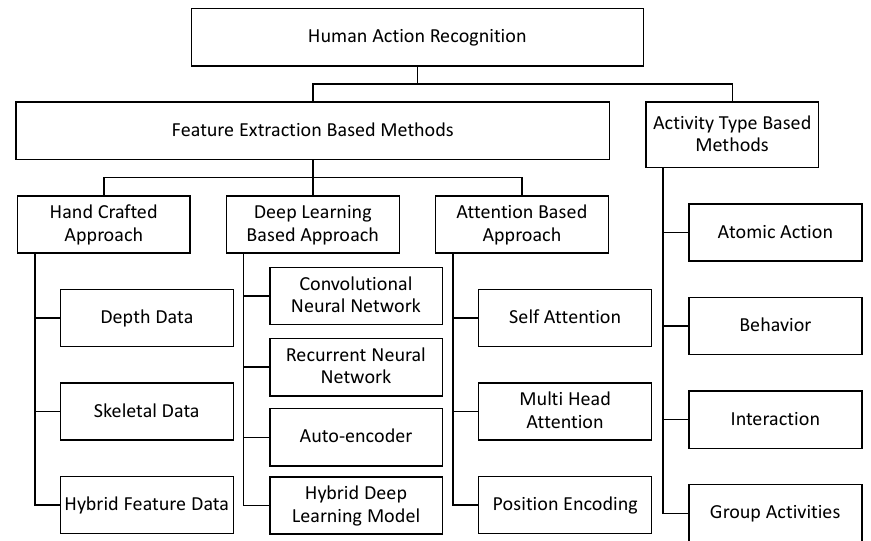
Figure 4. Human Action Recognition